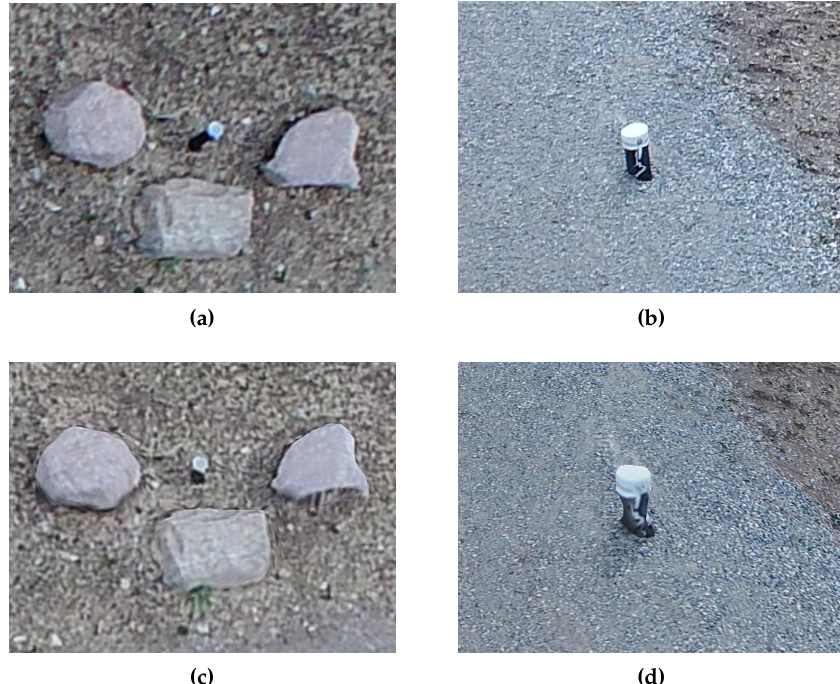
Figure 12. Visual comparisons of instrumentation features in ( c ) low and ( d ) high-priority regions. Corresponding photos are included in ( a , b ). Peizometer pipe in ( a , c ) is 11 cm in diameter and protrudes approximately 0.55 m from ground surface. Spillway drain access pipe in ( b , d ) is 17 cm in diameter and protrudes approximately 0.36 m from ground